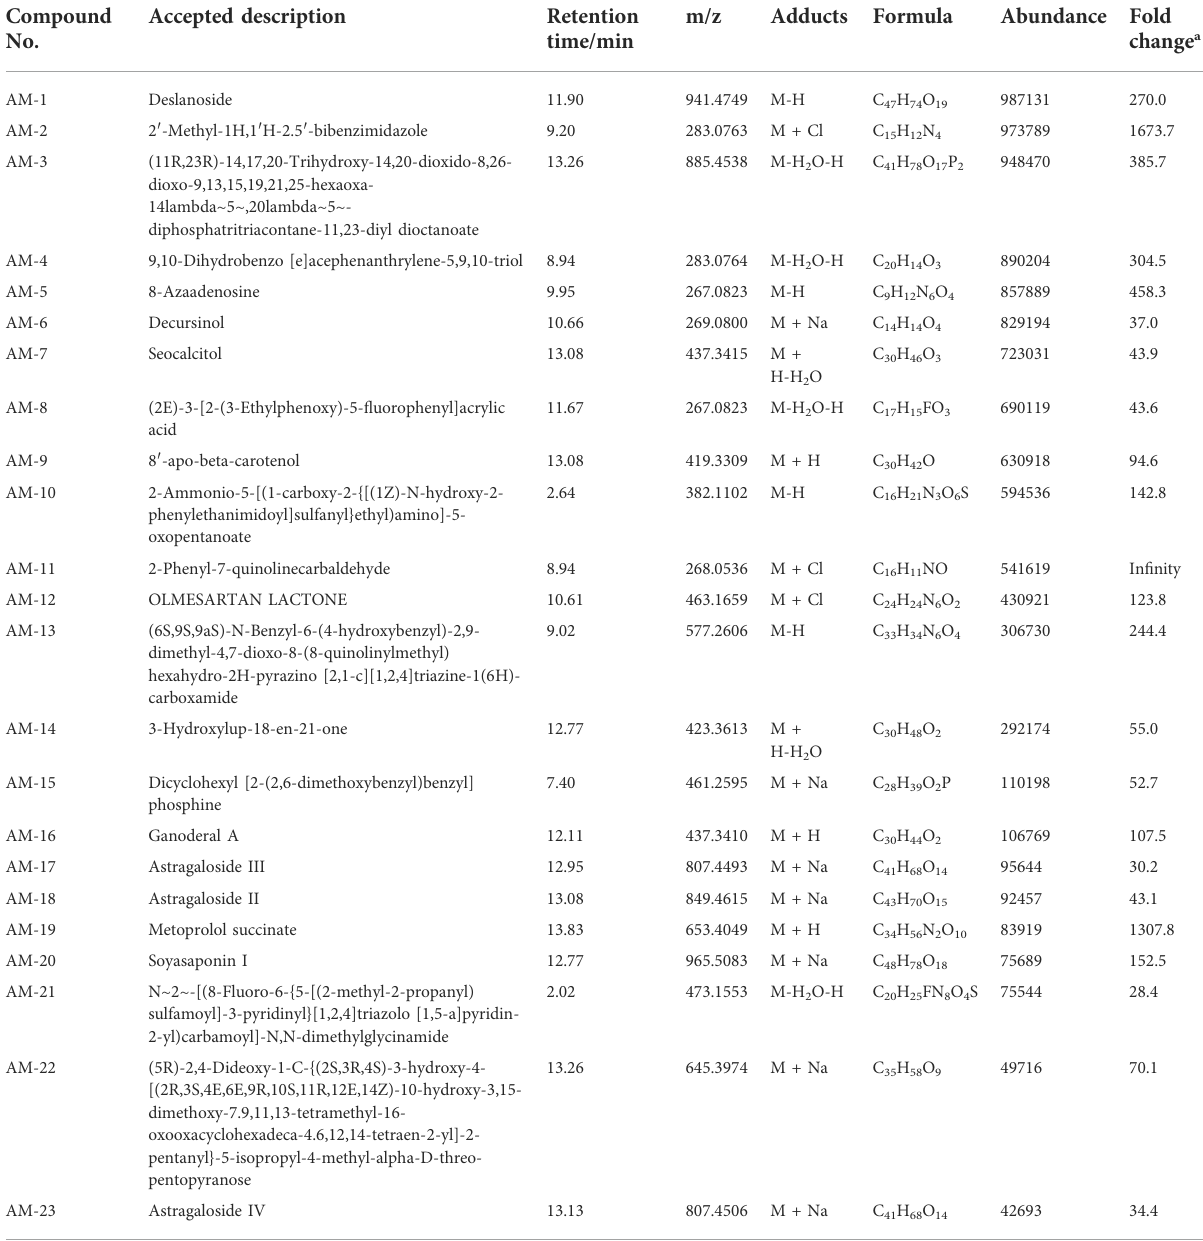
TABLE 2 Components identi fi ed in Astragalus mongholicus decoction. Compound